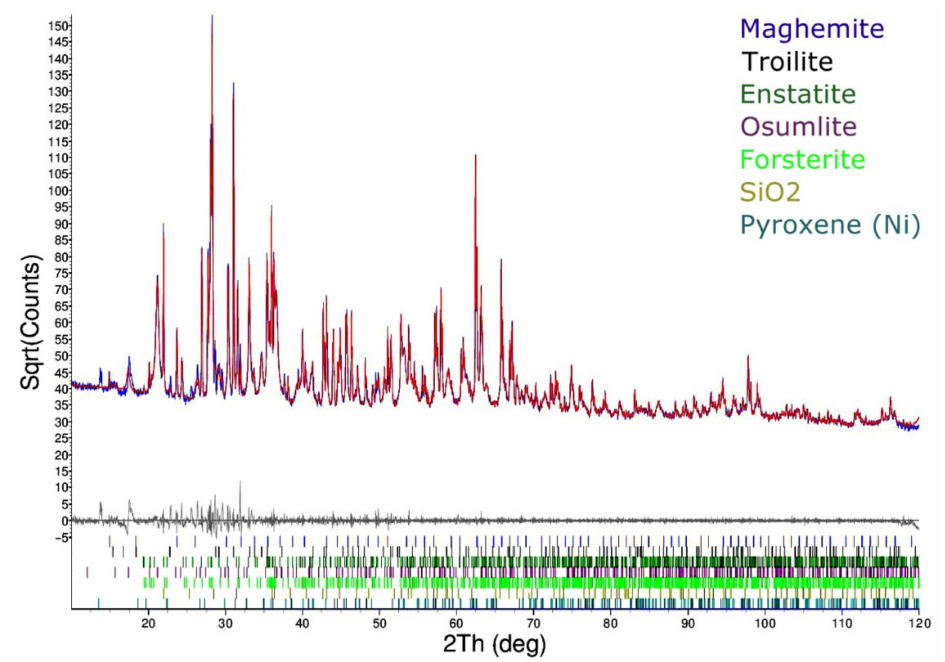
Figure 17. XRD pattern obtained at RT for the NWA 1990 stony meteorite and indexed phases. The mineral assemblage found in our unregistered stony meteorite indicates that it is probably an enstatite achondrite (aubrite) [50,51]. Dunlap studied an enstatite